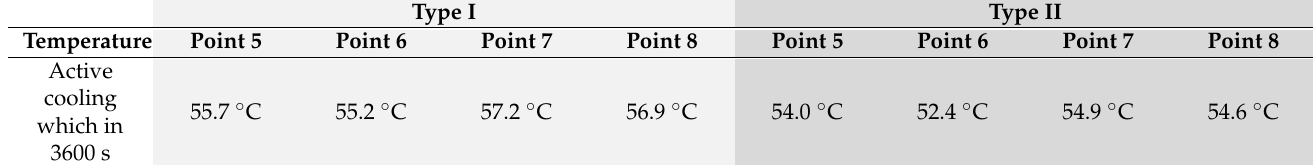
Figure 28. Dummy Heater and cold surface of the TEC temperature response. Figure 29. Thermal Resistance. 6. Conclusions In this study, we designed a high-performance heat dissipation module for 5G com- munication systems. Most active cooling systems are mainly designed with a combination of components such as fans, vapor coolers, or liquid coolers. They are not properly inte-